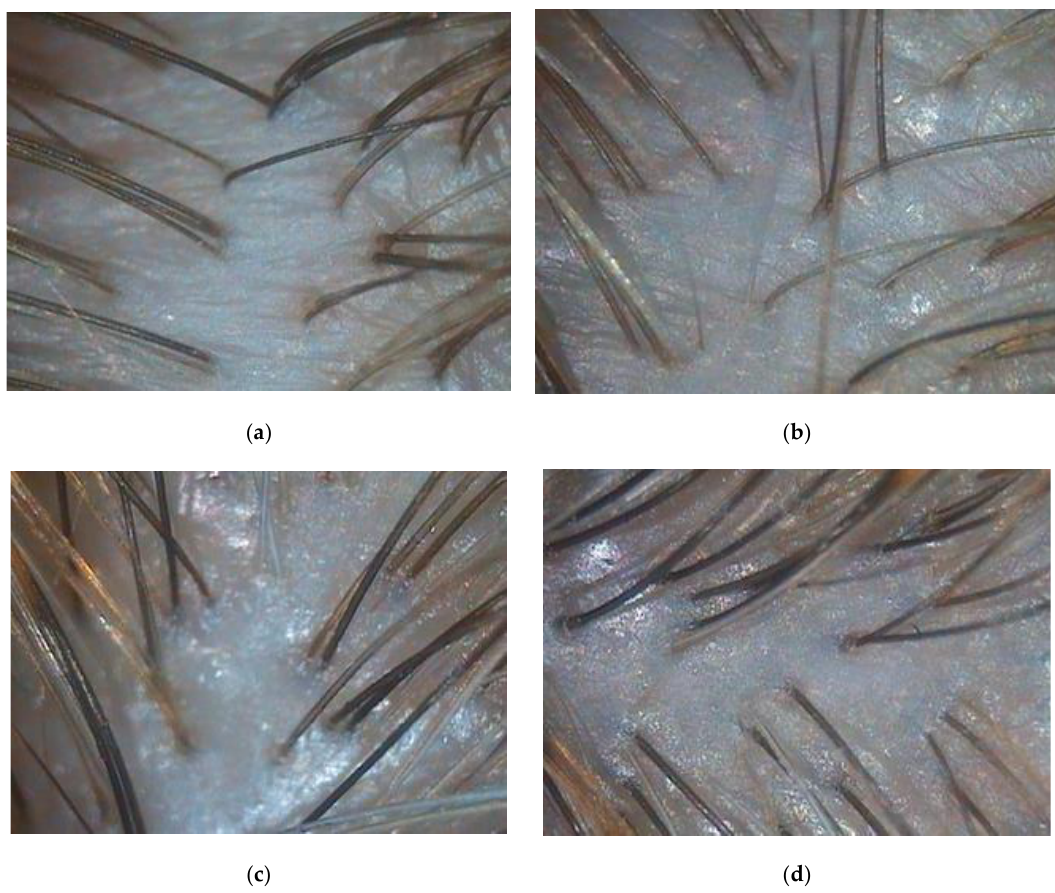
Figure A2. Microphotographs of hair density before and after the trial in the patient Ko-va of the placebo control Group 2. ( a ) Hair density on the frontal area before the trial; ( b ) hair density on the frontal area after the trial; ( c ) hair density on the occipital area before the trial; ( d ) hair density on the occipital area after the